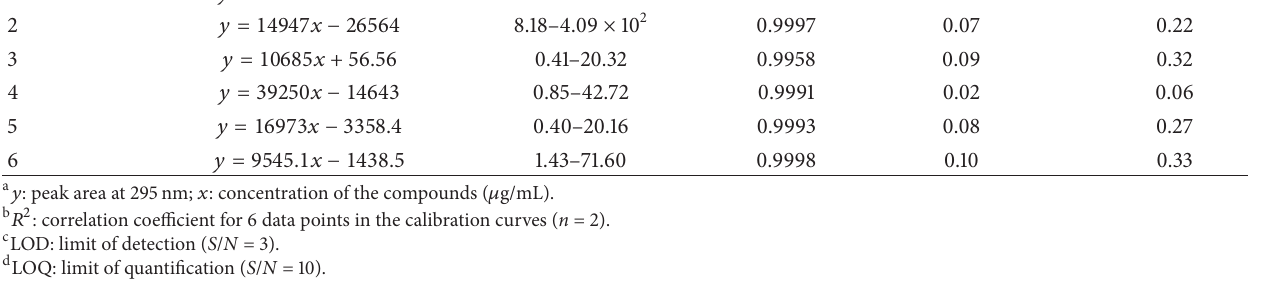
Table 2: Analytical results of intraday and interday precision and stability for the compounds in the rhizome of M. struthiopteris ( 𝑛 = 6 ). Compound no.